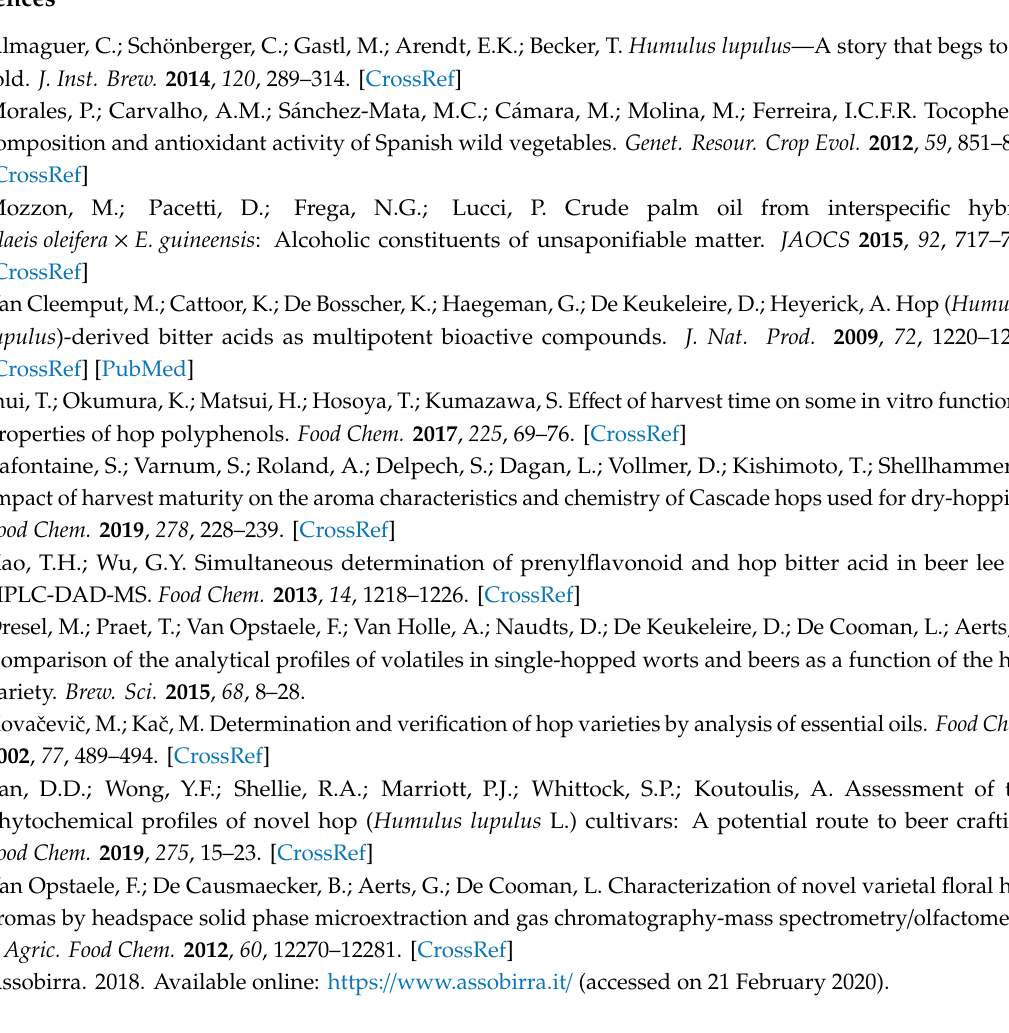
Figure S1: Headspace SPME-GC-MS profile (TIC, total ion current) of the of the Northern Brewer cultivar, Figure S2: Comparison among the headspace SPME-GC-MS profiles (TIC, total ion current) of fifteen hop varieties cultivated in the Marche region,